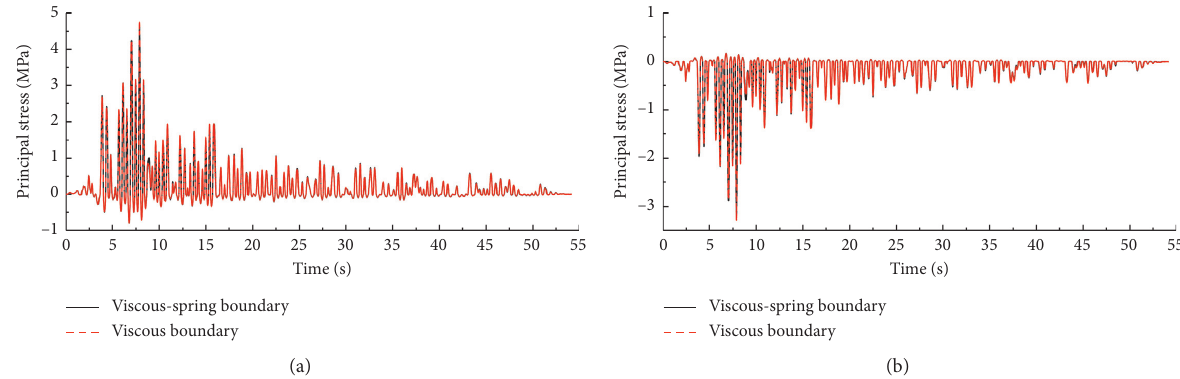
Figure 12: Time histories of principal stresses of the Pine Flat dam. (a) Principal tensile stress at dam heel. (b) Principal compressive stress at dam toe.